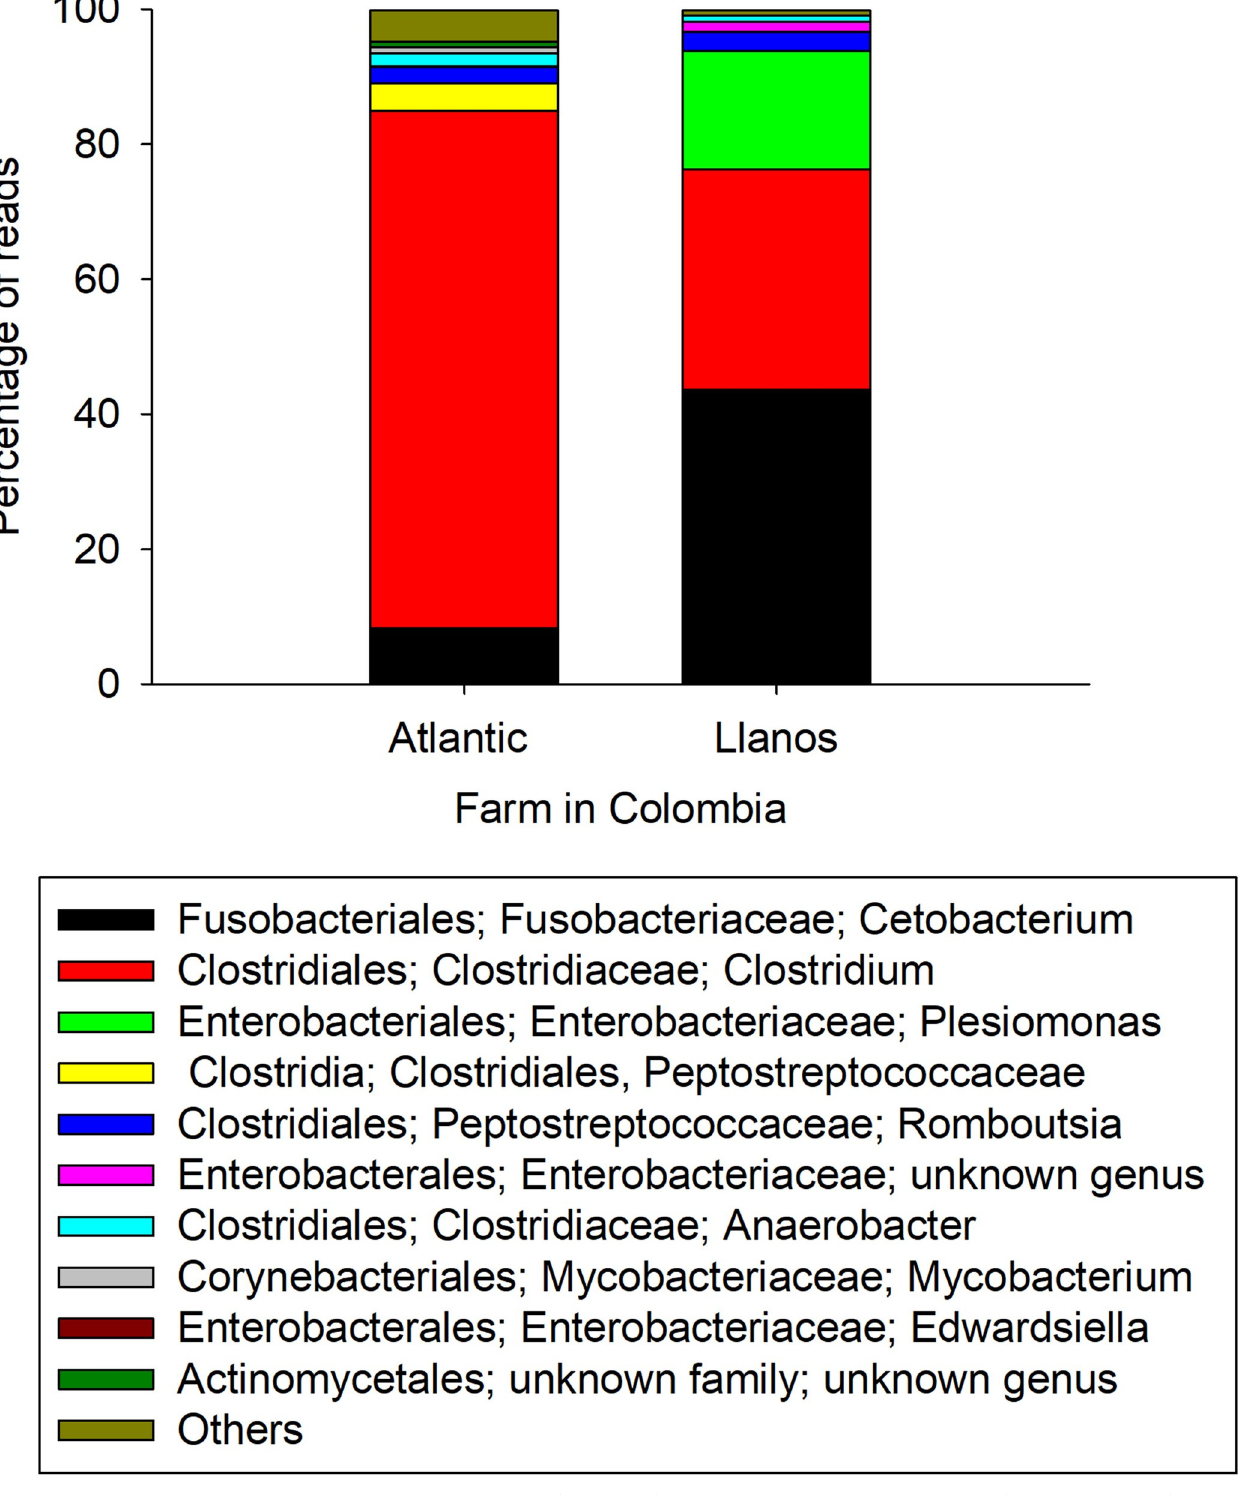
Fig 3. Relative abundance of intestinal bacteria genera of Nile tilapia ( O . niloticus ) from two Colombian aquaculture farms (Atlantic and Llanos).